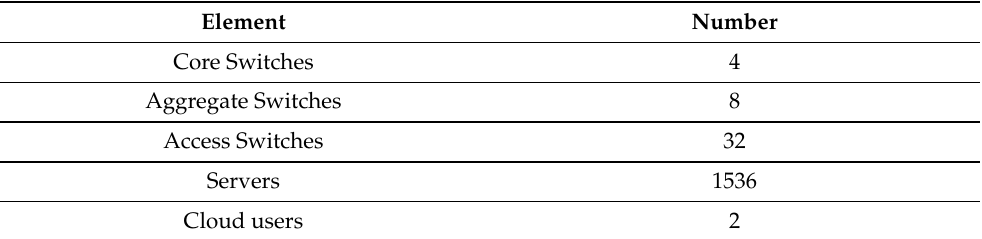
Table 2. DCN Topology